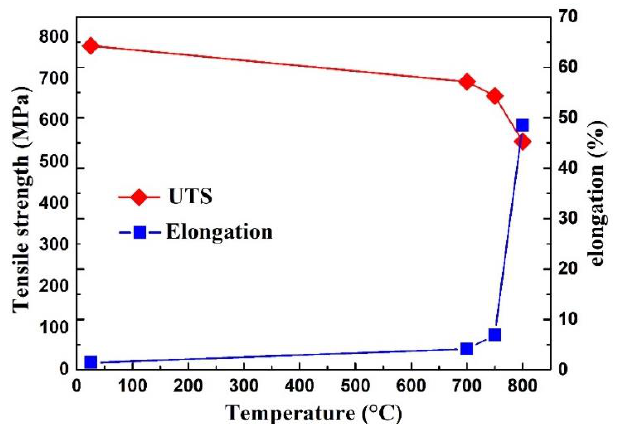
Figure 9. The dependence of tensile strength and elongation on temperature of the as-forged Ti–43Al–3Mn–2Nb–0.1Y billet.